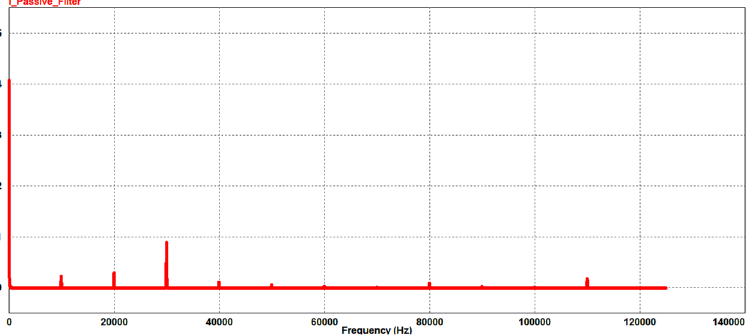
Figure 13. FFT analysis of the input current waveform of an IH system with a passive filter.